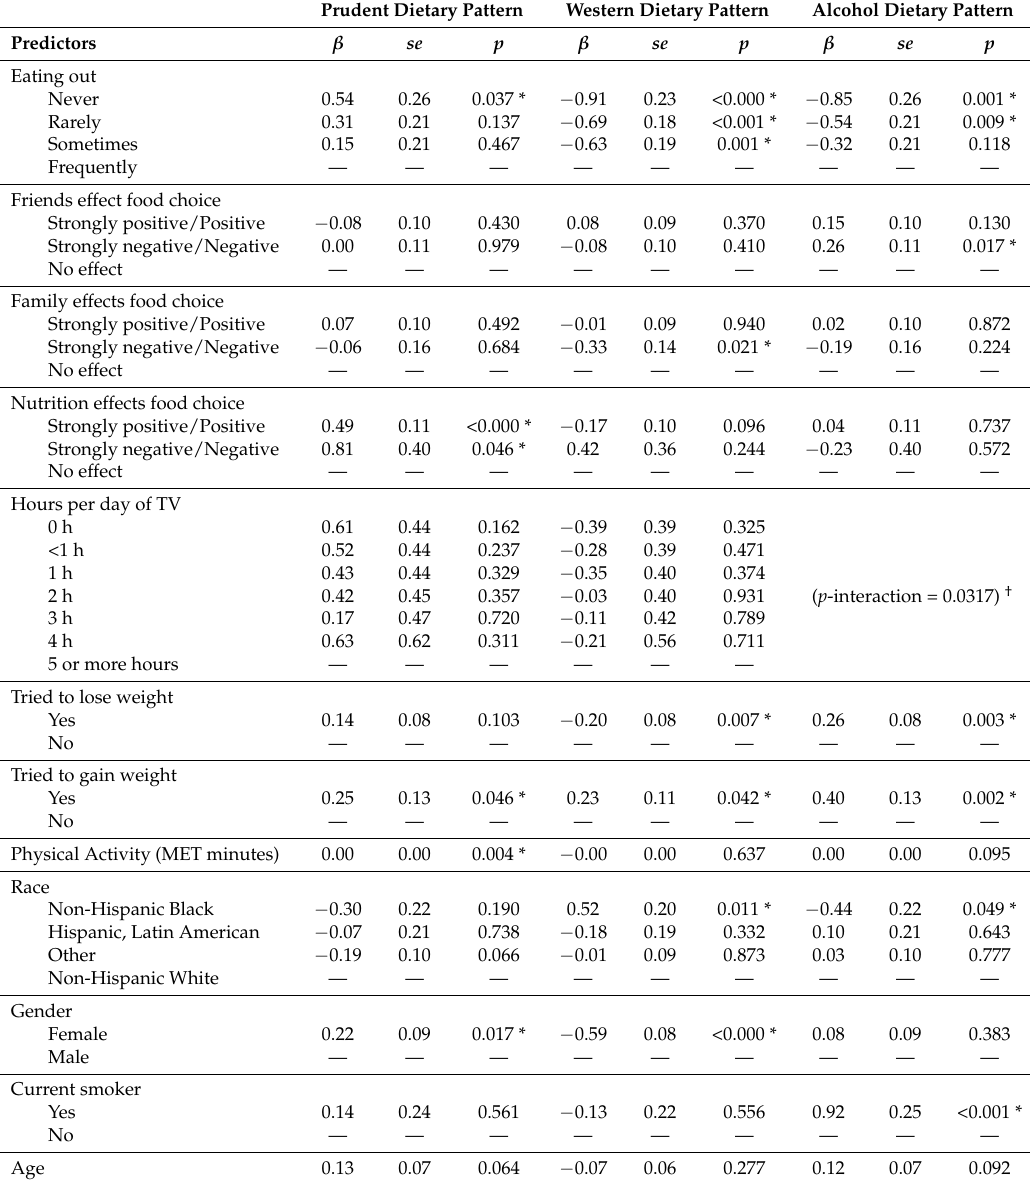
Table 2. Associations between behavioral factors and dietary pattern scores ( n = 630). Prudent Dietary Pattern Western Dietary Pattern Alcohol Dietary Pattern Predictors β